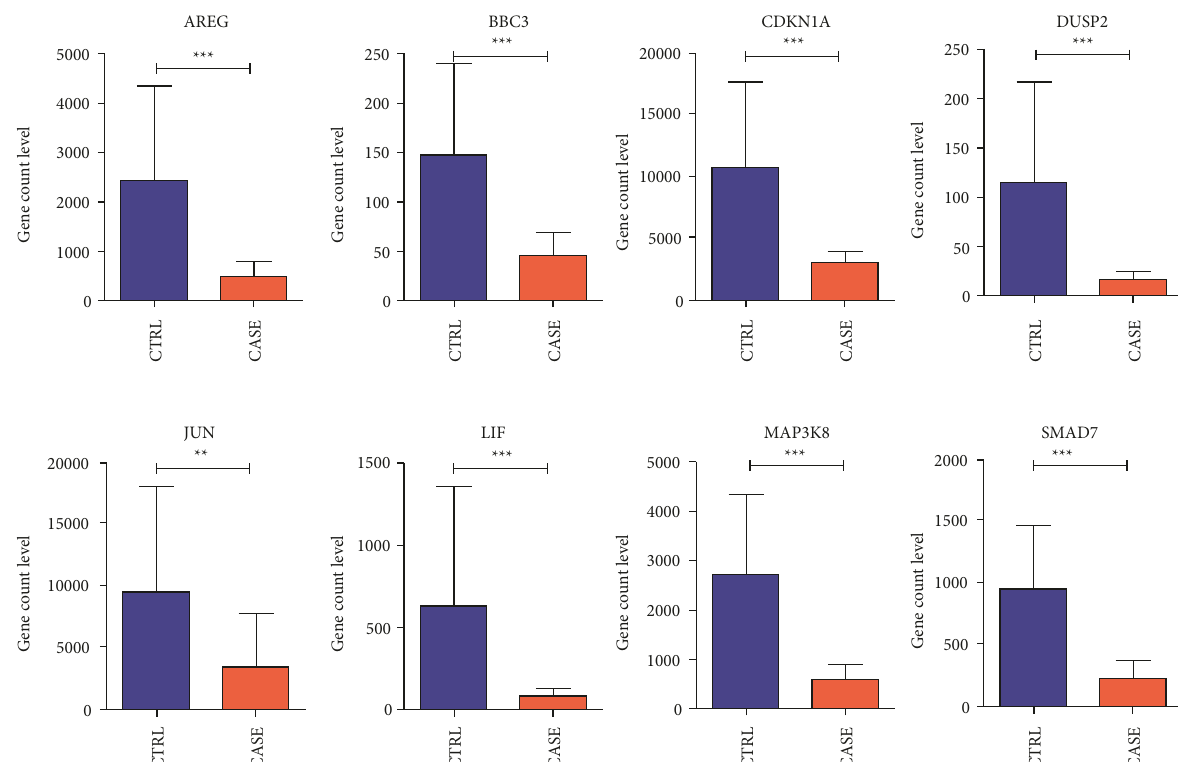
Figure 10: We visually displayed the expression levels of 8 genes in the combined sample, as shown in Figure